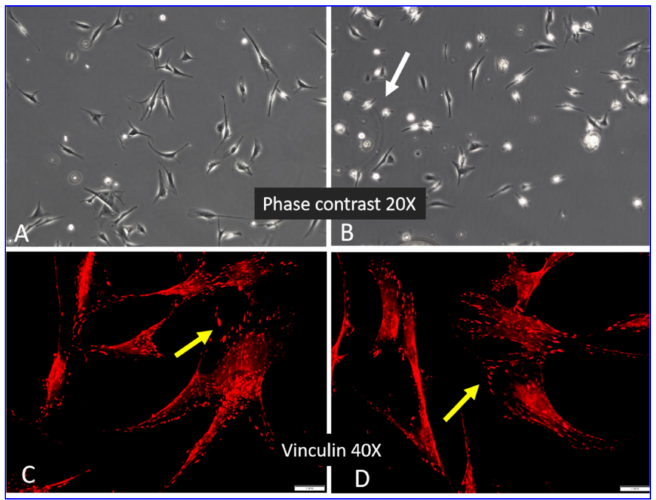
Figure 2. Initial adhesion at 2 h ( A , B ) and subsequent spreading after 24 h ( C , D ) of ADMSCs adhered to Col I ( A , C ) and Col I-OXI ( B , D ). Top row-cells imaged under phase contrast (20 × ); bottom row-focal adhesions viewed by staining for vinculin (40 × ). Scalebar 20 µ m.